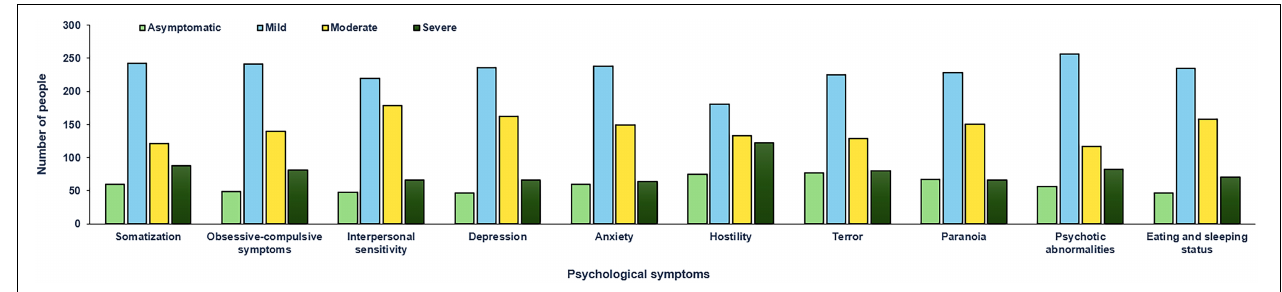
FIGURE 1 | Distribution characteristics of psychological symptoms among 511 resident